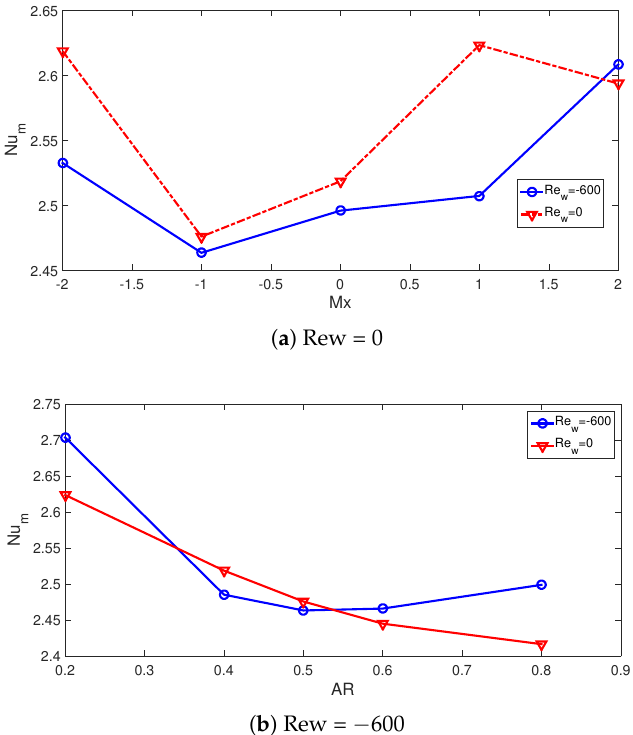
Figure 13. Average Nu versus ( a ) location and ( b ) aspect ratio of the porous object (Ha = 10, Da = 5 × 10 − 2 ).